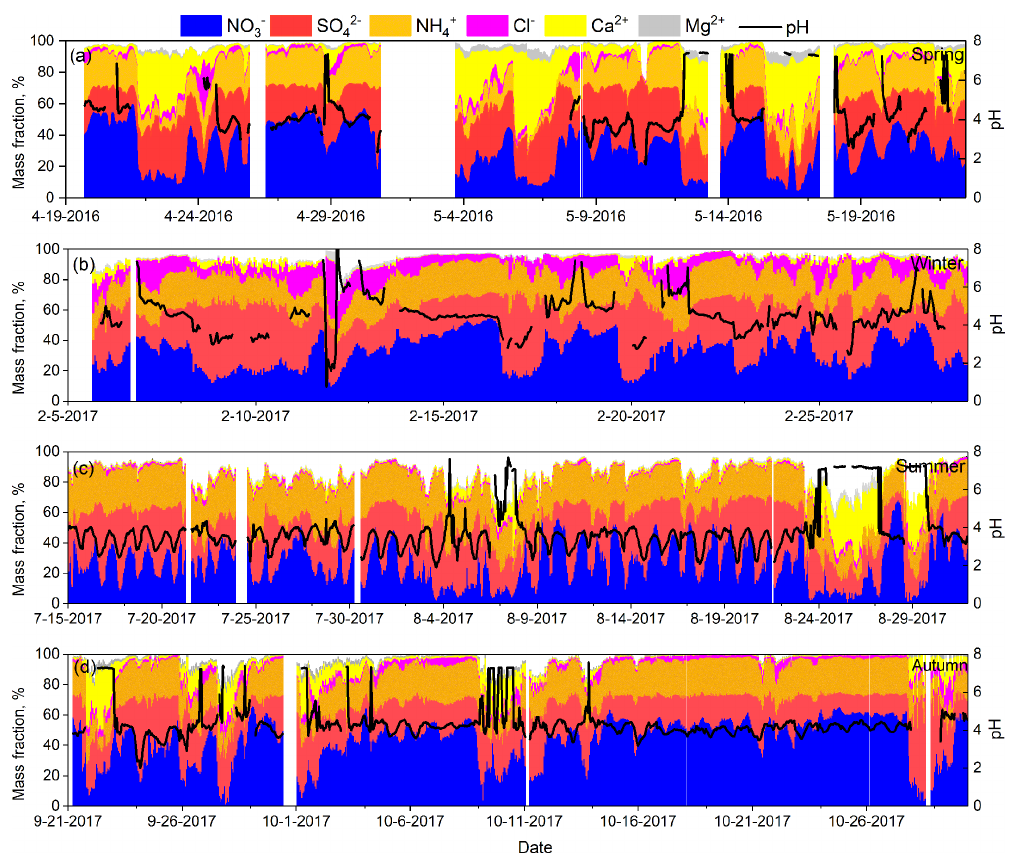
Figure 4. Time series of mass fractions of NO − pH in all four seasons (PM 2 . 5 pH values at RH ≤ 30% were excluded).